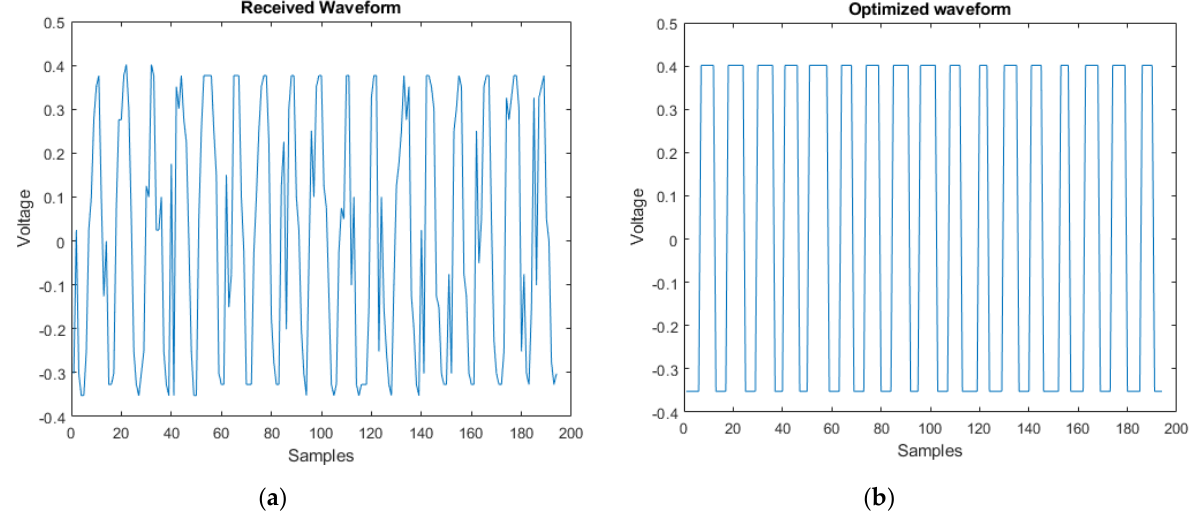
Figure 8. ( a ) The received signal (before DPE) and ( b ) after